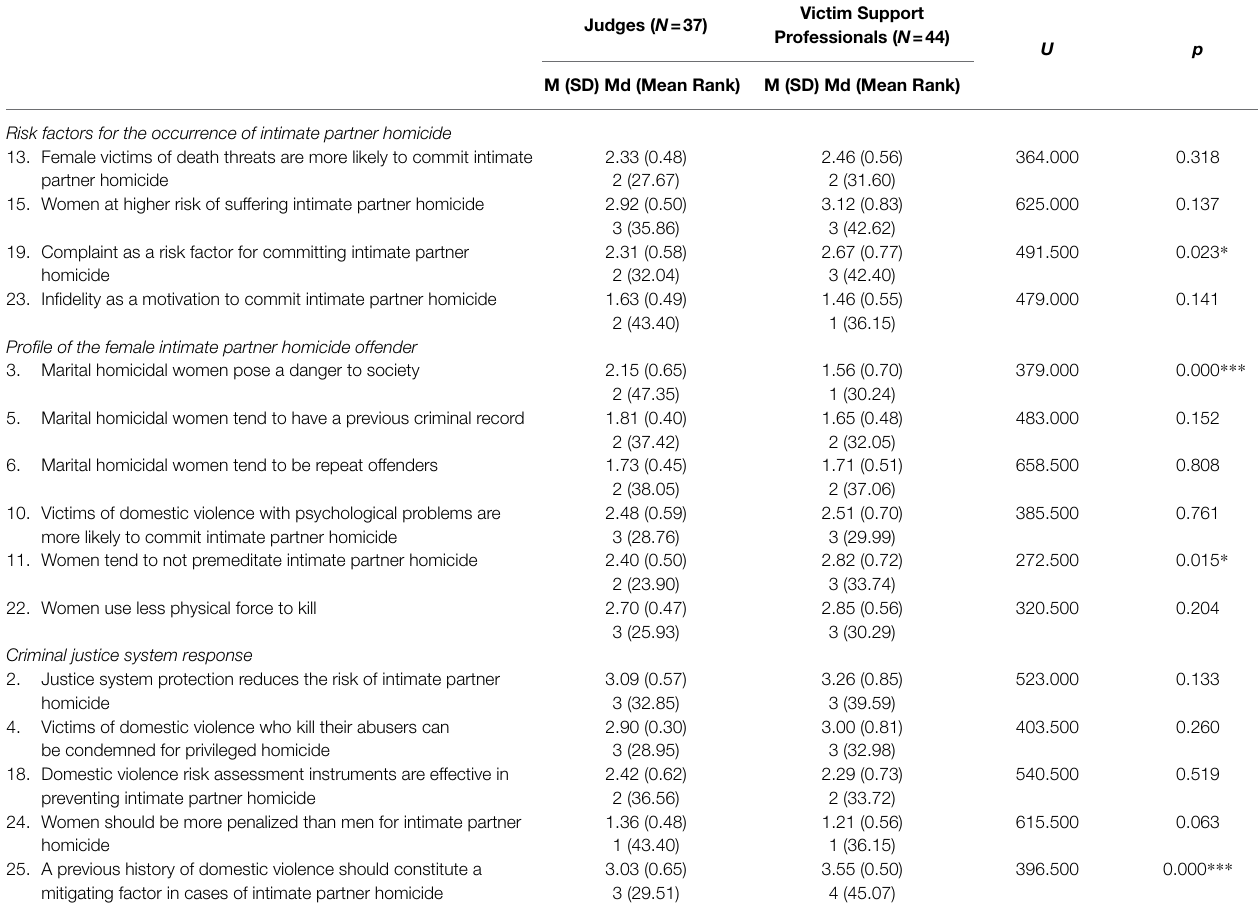
TABLE 2 | Evaluation of attitudes of Portuguese judges and victim support professionals about intimate partner